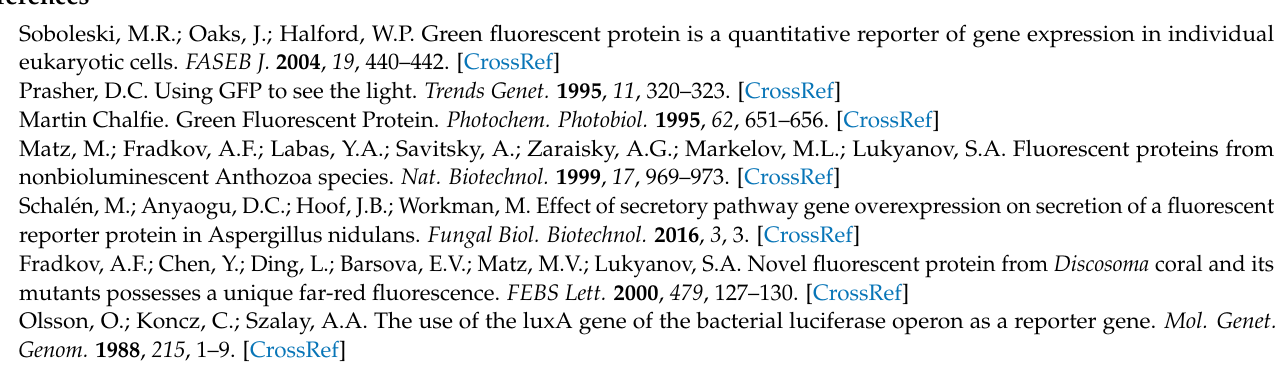
Figure S9: Long-term fluorescence kinetics of the proposed OM biosensor to well-known model peptides; Figure S10: Long-term fluorescence kinetics of the proposed OM biosensor to novel cyclic peptide derivatives; Figure S11: Map of the plasmid pMM001 (Benchling.com; accessed on 2 Decem- ber 2022); Figure S12: PMB induces population-wide fluorescence of UnaG-expressing E. coli cells; Figure S13: The influence of bacterial density on UnaG fluorescence; Table S1: Antimicrobial activity (MIC in µ g/mL); Sequence S1: DNA sequence of the plasmid